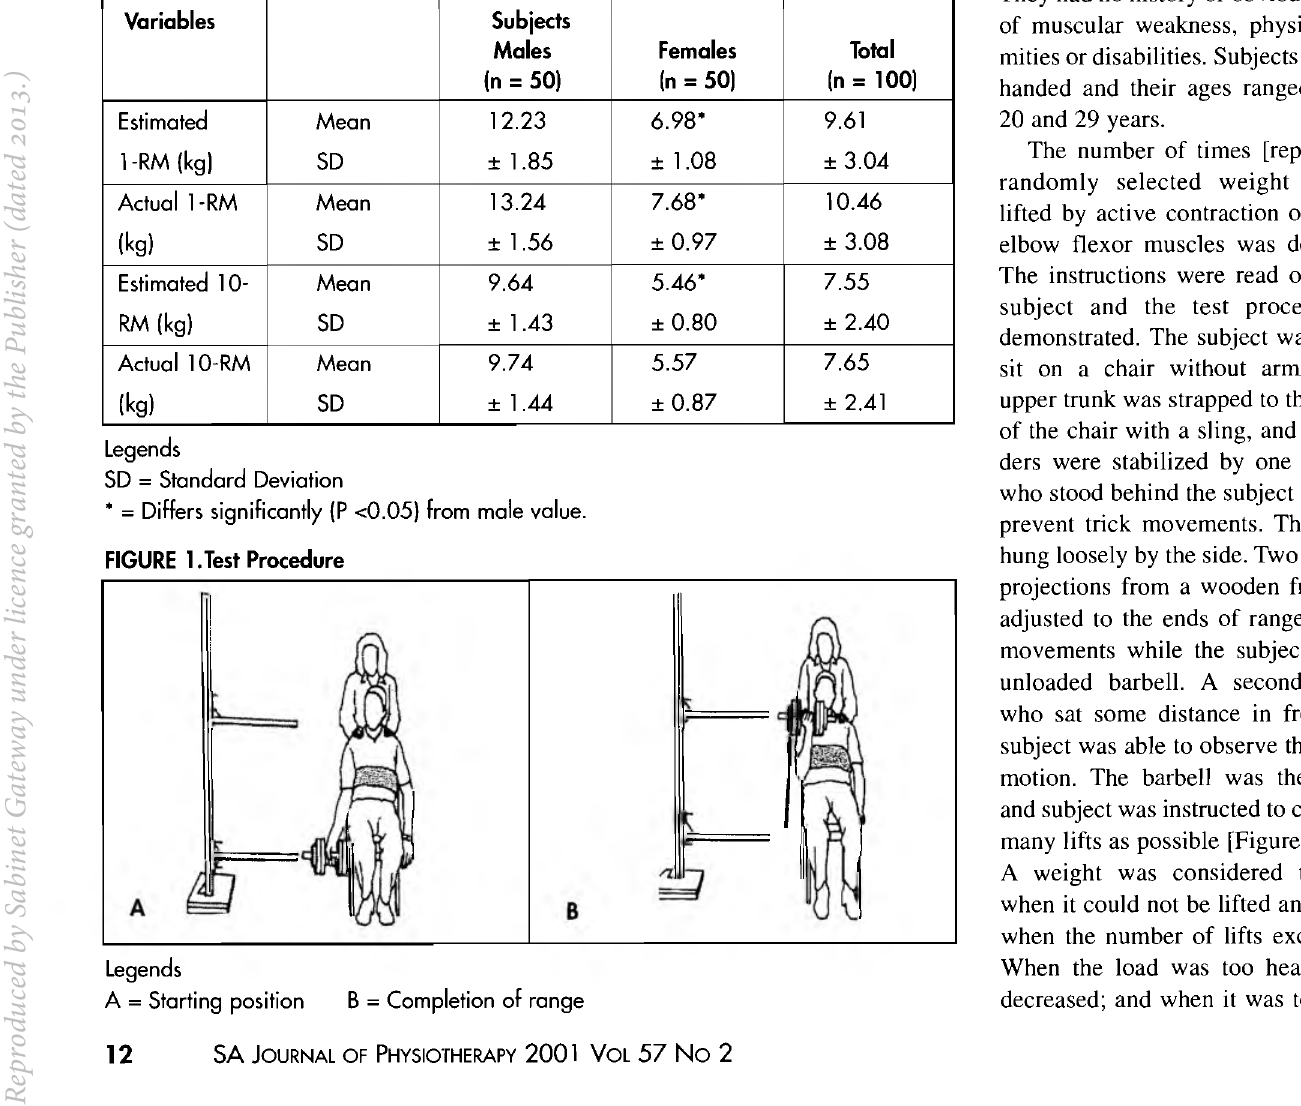
TABLE 2. Means and standard deviations of 1-RM and 10-RM